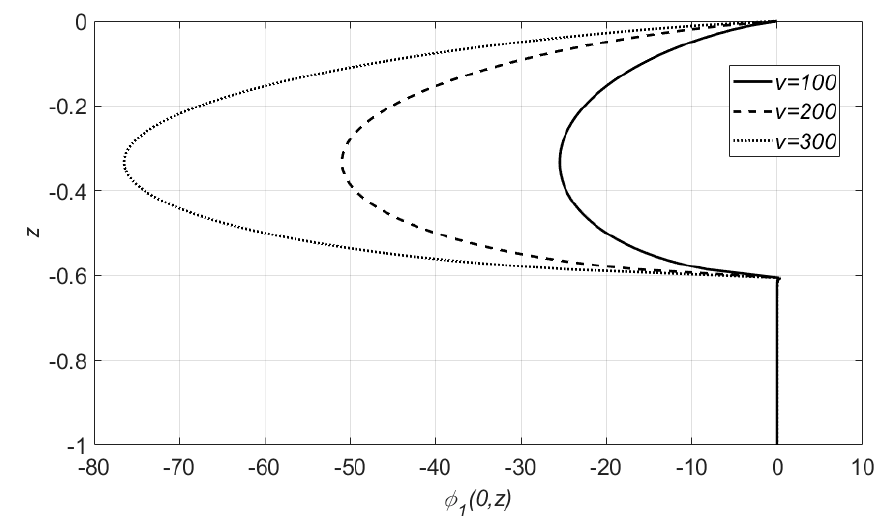
Figure 4. First order velocity potentials on the wall, φ 1 ( 0, z ) , for several wave impact velocities and fixed air cavity position − 1 ≤ z cavity ≤ − 0.6 at t = 0.01 s